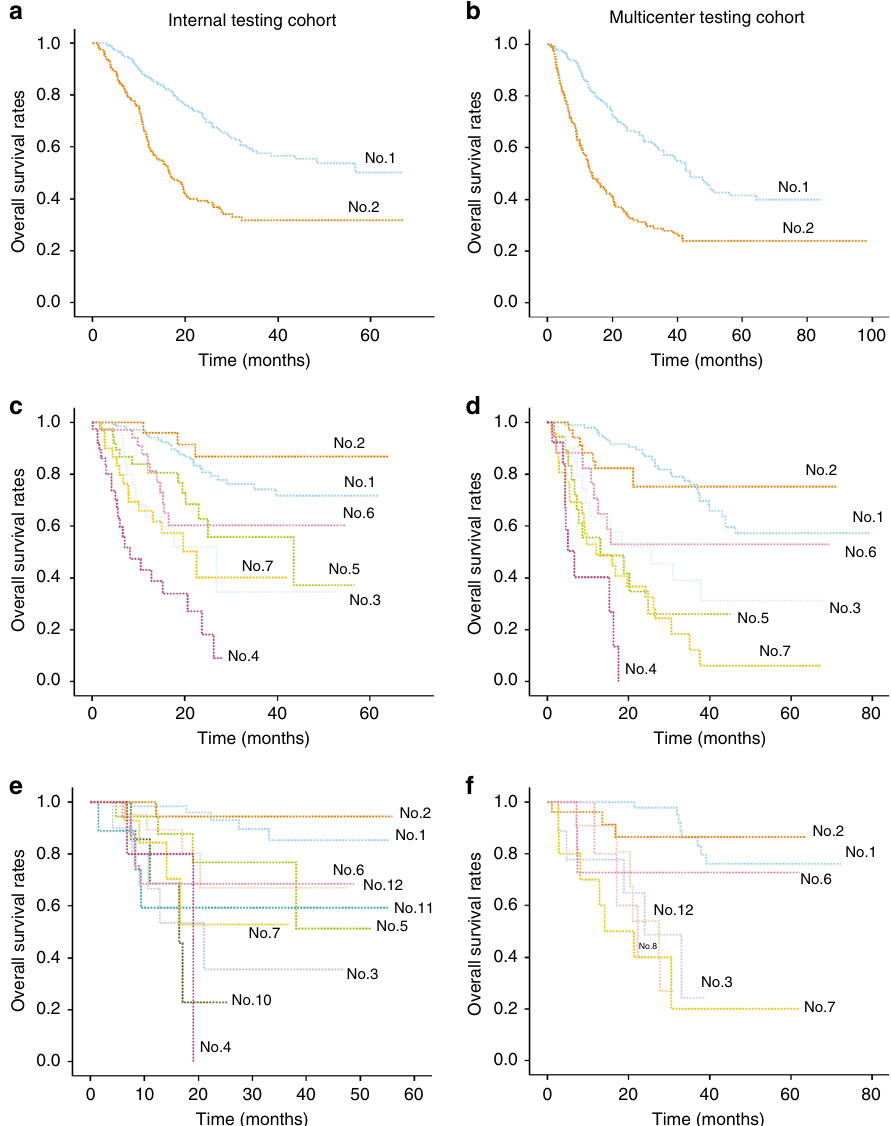
Fig. 3 Kaplan – Meier plots in the validation cohorts. Kaplan – Meier plots showed OS divided by the survival path system in the internal testing cohort and multicenter testing cohort, respectively, at time slice No.1 ( a , b ), time slice No.3 ( c , d ), and time slice No.5 ( e , f ). Note: nodes of paths with <6 cases in the testing cohorts were regarded unstable and not included in the